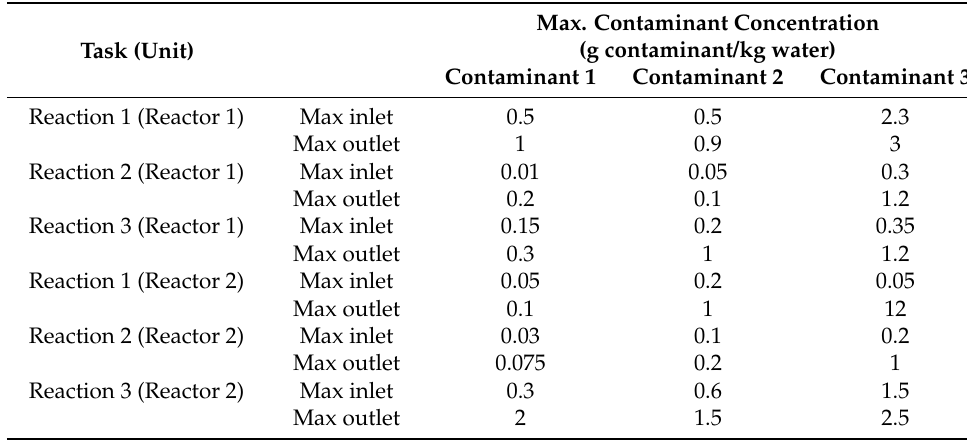
Table A6. Input data for washing of the reactor units for case study 2